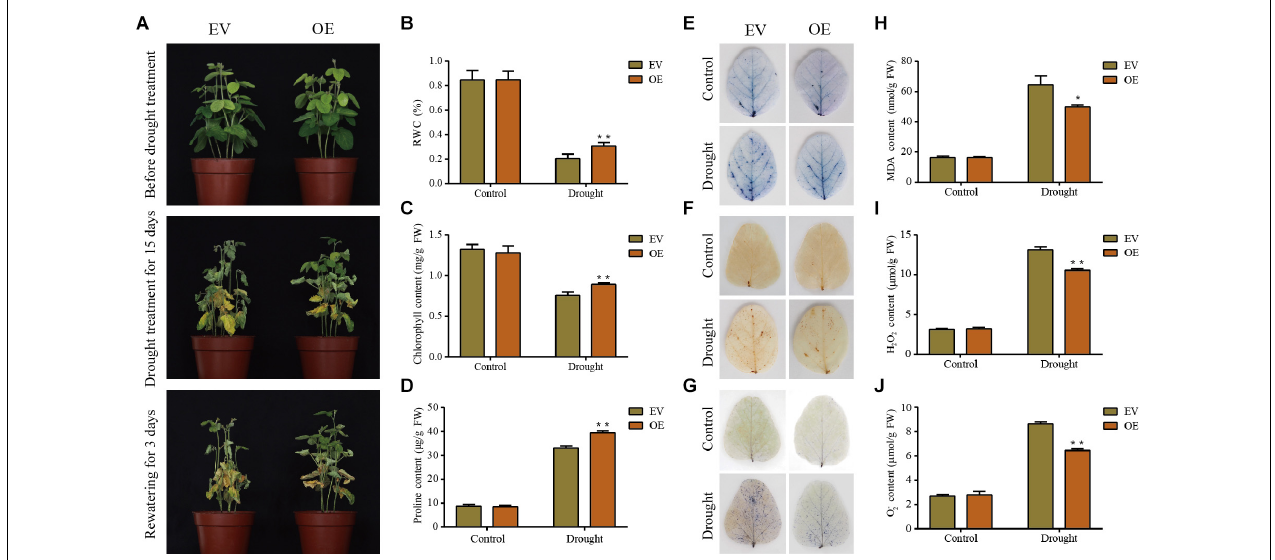
FIGURE 8 | Phenotypic and physiological analyses of the transgenic empty vector (EV) lines and GmDUF4228-70 -OE (OE) transgenic lines under drought stress. (A) Phenotypes of EV and GmDUF4228-70- OE transgenic soybean plants treated under drought stress for 15 days and rewatering for 3 days. Relative water content (RWC) (B) , chlorophyll content (C) , proline content (D) , trypan blue staining (E) DAB staining (F) , NBT staining (G) , Malondialdehyde (MDA) content (H) H